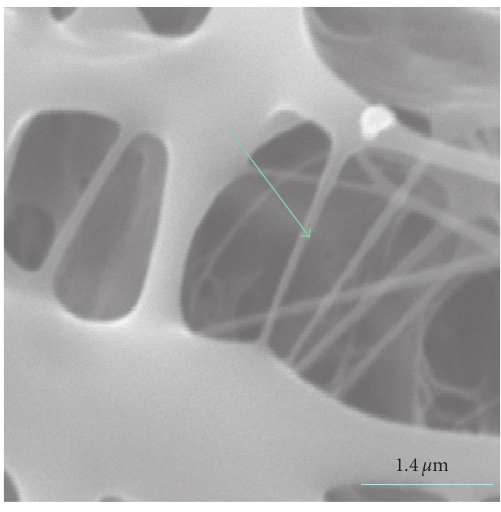
Figure 10: SEM image of collagen film surface after laser irradia- tion, ( F = 3 J/cm 2 , 1 pulse, scale bar is 1.4 μ m). Green arrow shows ultra-thin fibers with nanometric